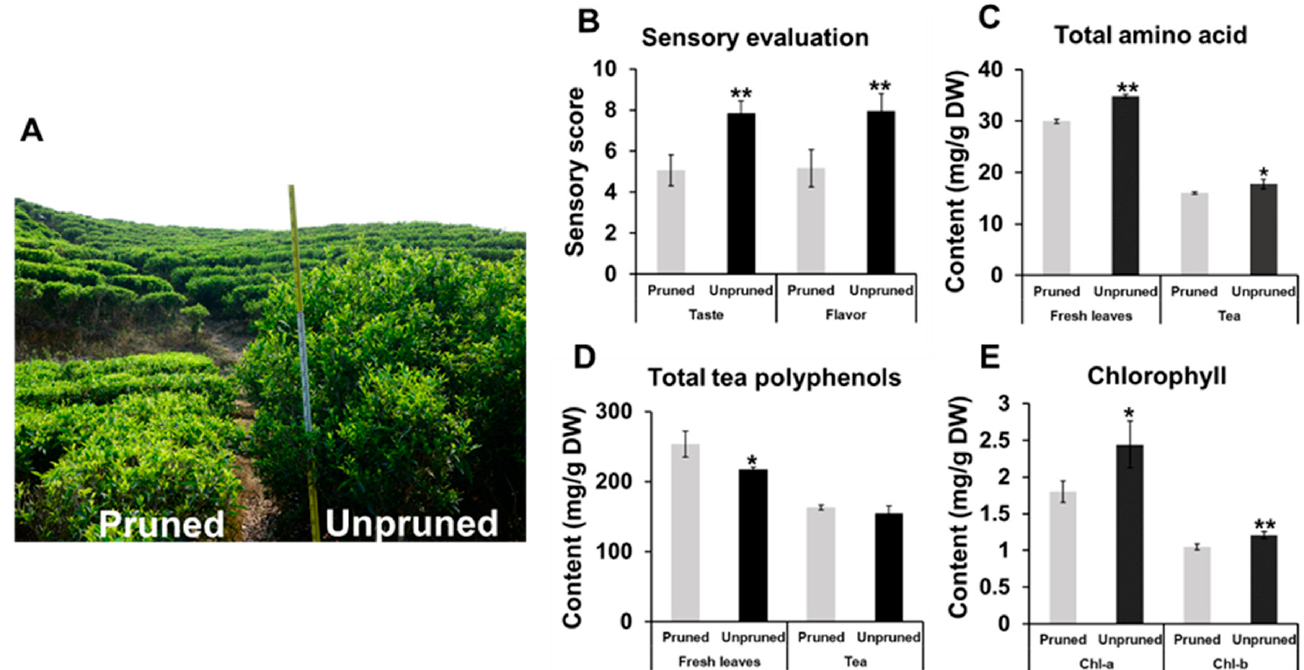
Figure 1. Phenotypes ( A ), sensory evaluation score ( B ), total contents of free amino acids ( C ), total contents of tea polyphenol ( D ), contents of chlorophylls ( E ) in tea leaves from long-term unpruned and pruned tea plants. Data is presented as mean ± SD. * represents significant difference ( p < 0.05), ** represents extremely significant difference ( p < 0.01).